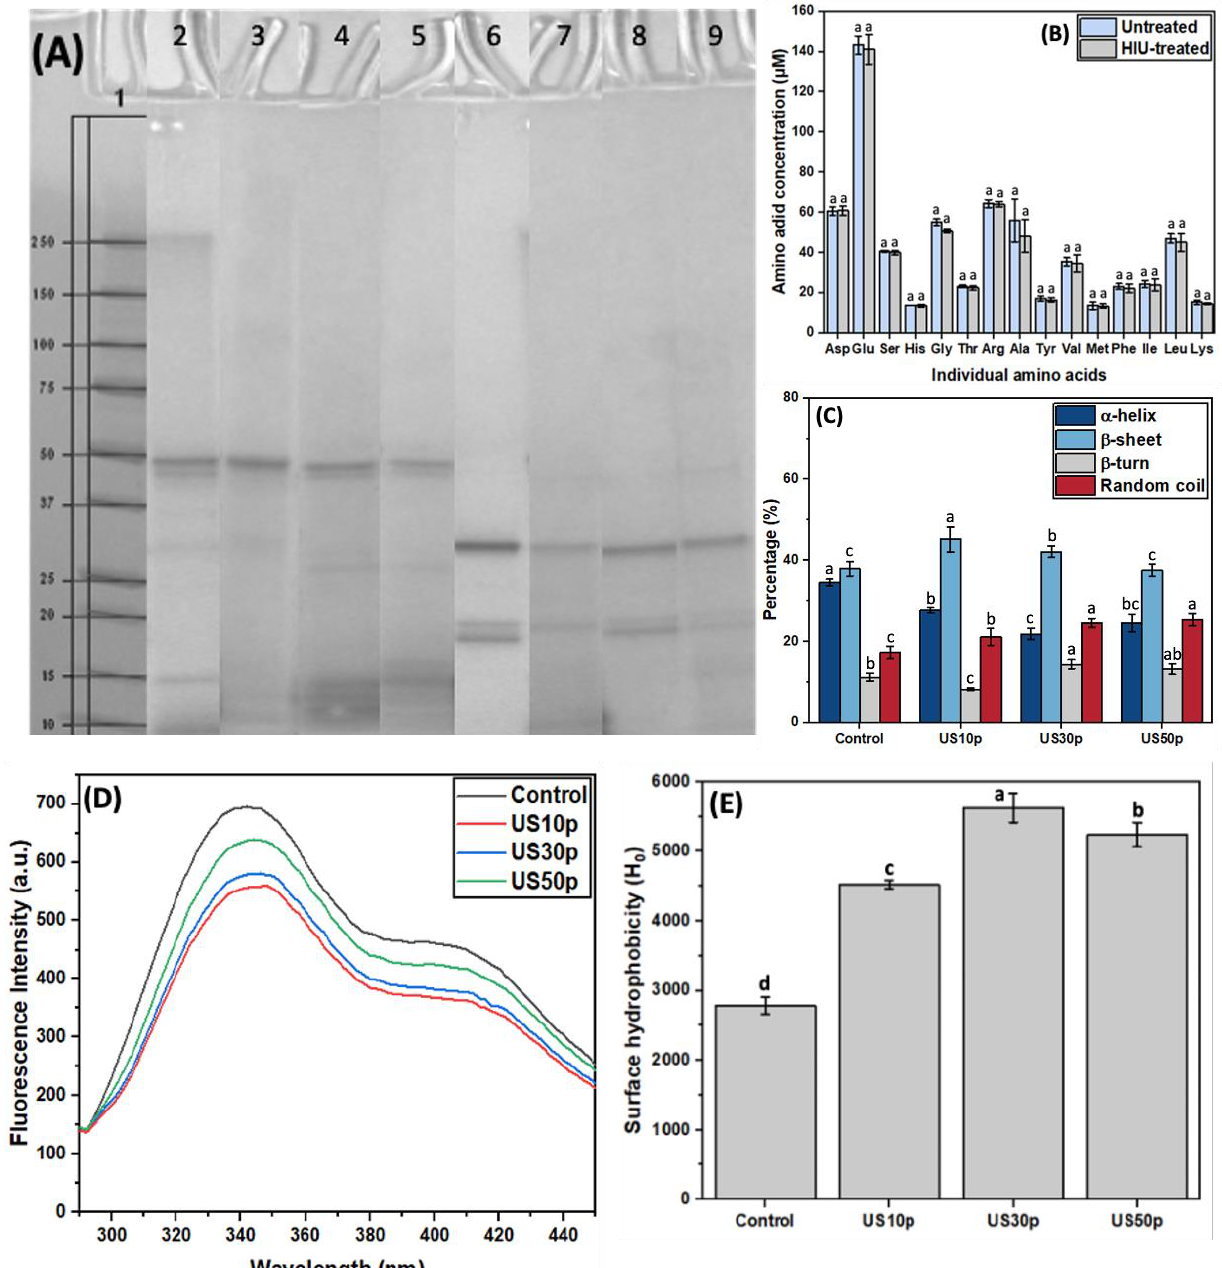
Figure 2. ( A ) SDS-PAGE profiles of control HPI and US-treated HPI with (reducing) or without (non- reducing) the addition of β -ME. Lanes in SDS-PAGE profiles: Lane 1: Marker; Lane 2: Conventionally extracted HPI; Lane 3: 11.2 W/cm 2 , 5 min US; Lane 4: 26.8 W/cm 2 , 5 min US; Lane 5: 50.0 W/cm 2 , 5 min US. Lanes 2–5 are under non-reducing conditions, whereas lanes 6–9 are their corresponding reducing SDS-PAGE profiles; ( B ) The amino acid profiles of untreated HPI and HIU-treated HPI; ( C ) The secondary structure of untreated and US-treated HPI under different power densities (11.2, 26.8, and 50.0 W/cm 2 for 5 min); ( D ) Fluorescence spectra indicating tertiary structural differences between conventionally extracted and US-treated HPI under different power densities (11.2, 26.8, and 50.0 W/cm 2 for 5 min); ( E ) Changes in surface hydrophobicity (H 0 ) of conventionally and high-intensity ultrasound extracted (11.2, 26.8, and 50.0 W/cm 2 for 5 min) HPI. The experiments were conducted in triplicate. Different lowercase letters in ( B , C , E ) represent the significant differences among different US treatments ( p < 0.05).